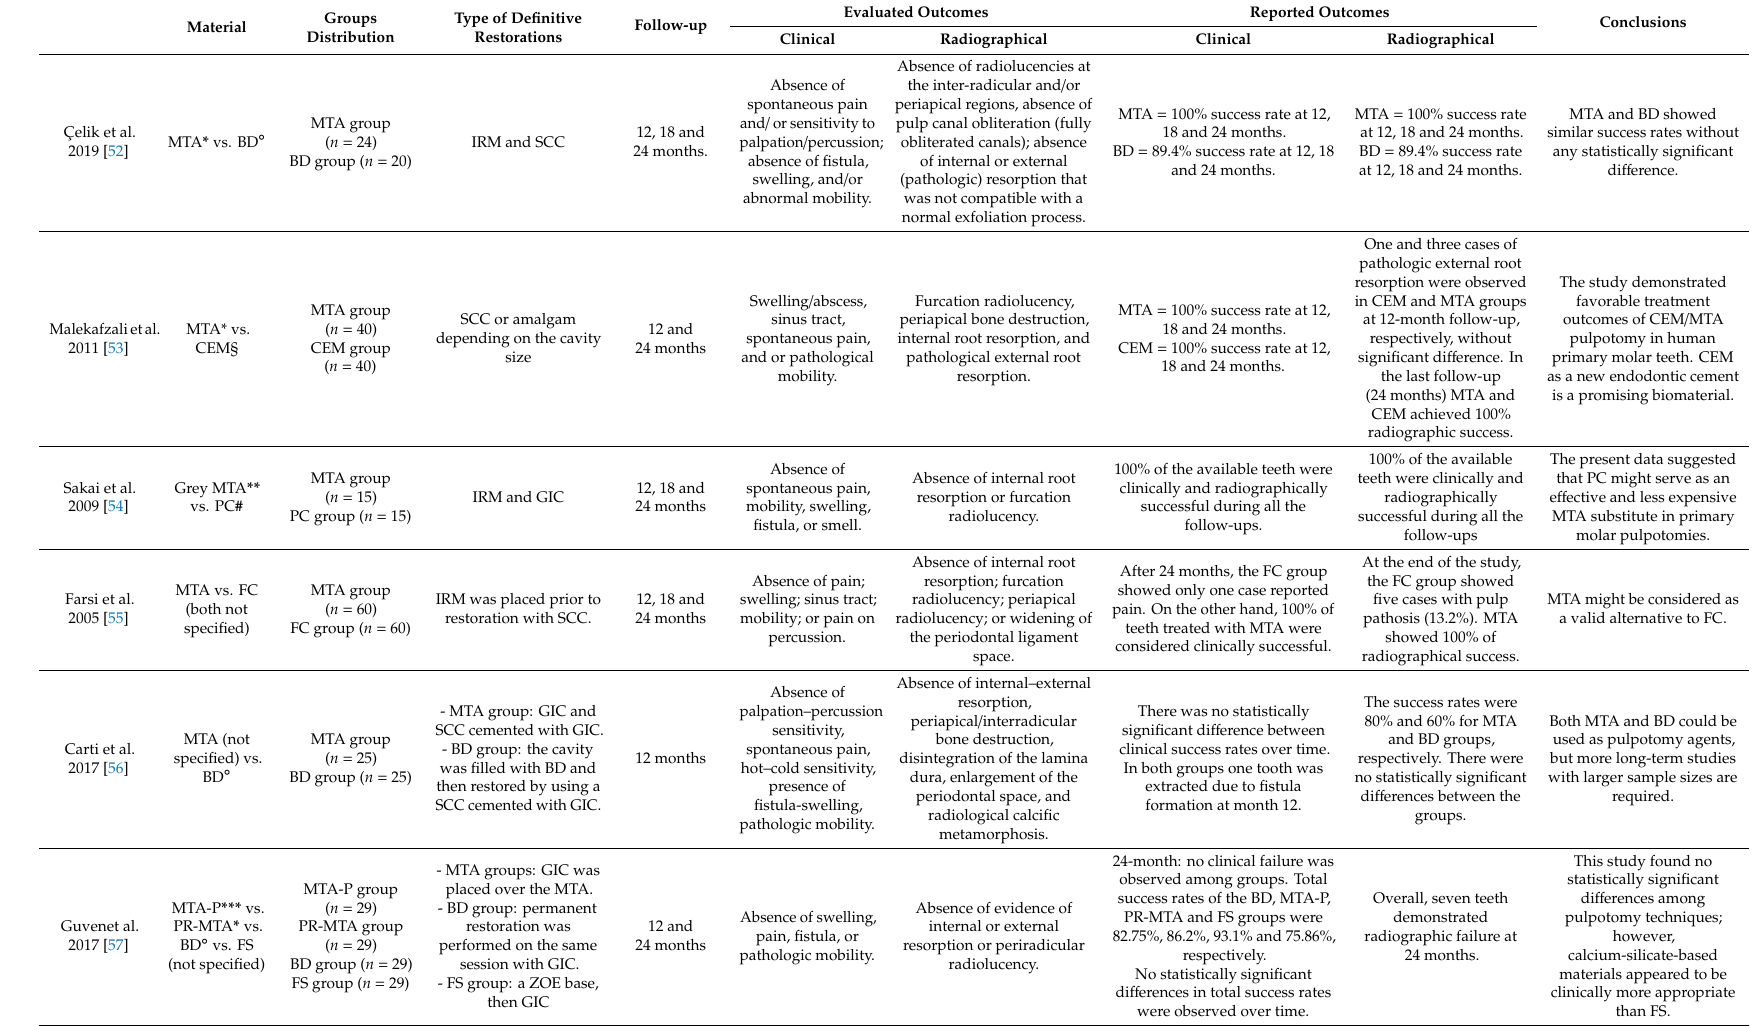
Table 3. Summary of the data reported in the studies included in the present systematic